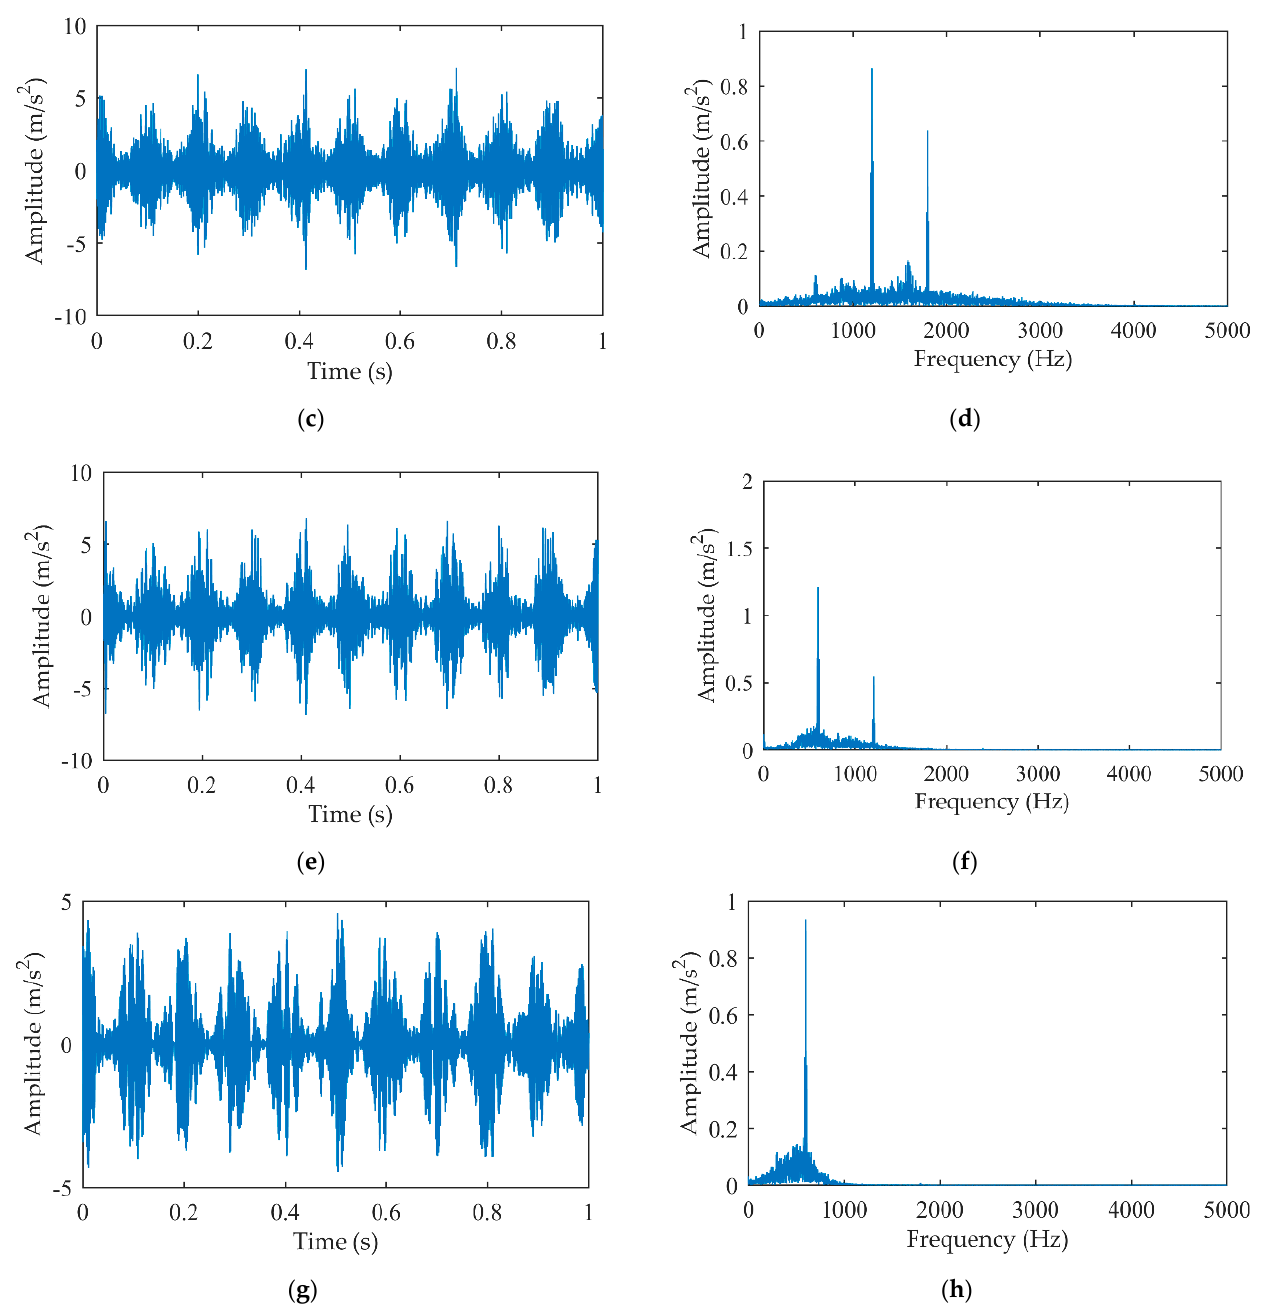
Figure 3. The first four IMFs of the simulation signal: ( a ) IMF1; ( b ) Amplitude spectrum of IMF1; ( c ) IMF2; ( d ) Amplitude spectrum of IMF2; ( e ) IMF3; ( f ) Amplitude spectrum of IMF3; ( g ) IMF4; ( h ) Amplitude spectrum of IMF4. Table 1. The kurtosis of the first four IMFs